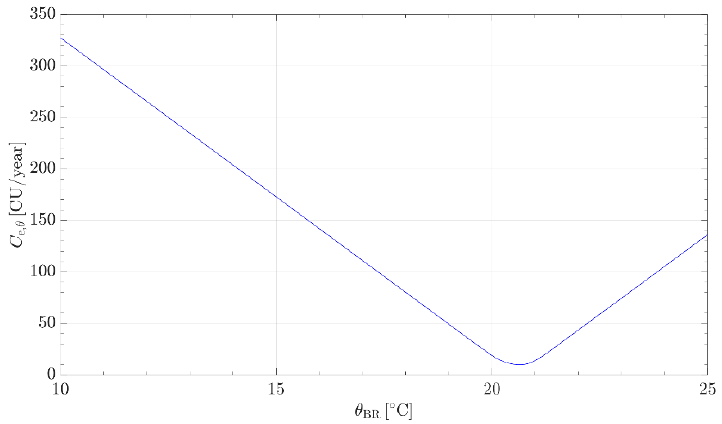
Figure 11. Annual costs of the HVAC device in the BR for various BR temperatures in a large substation.